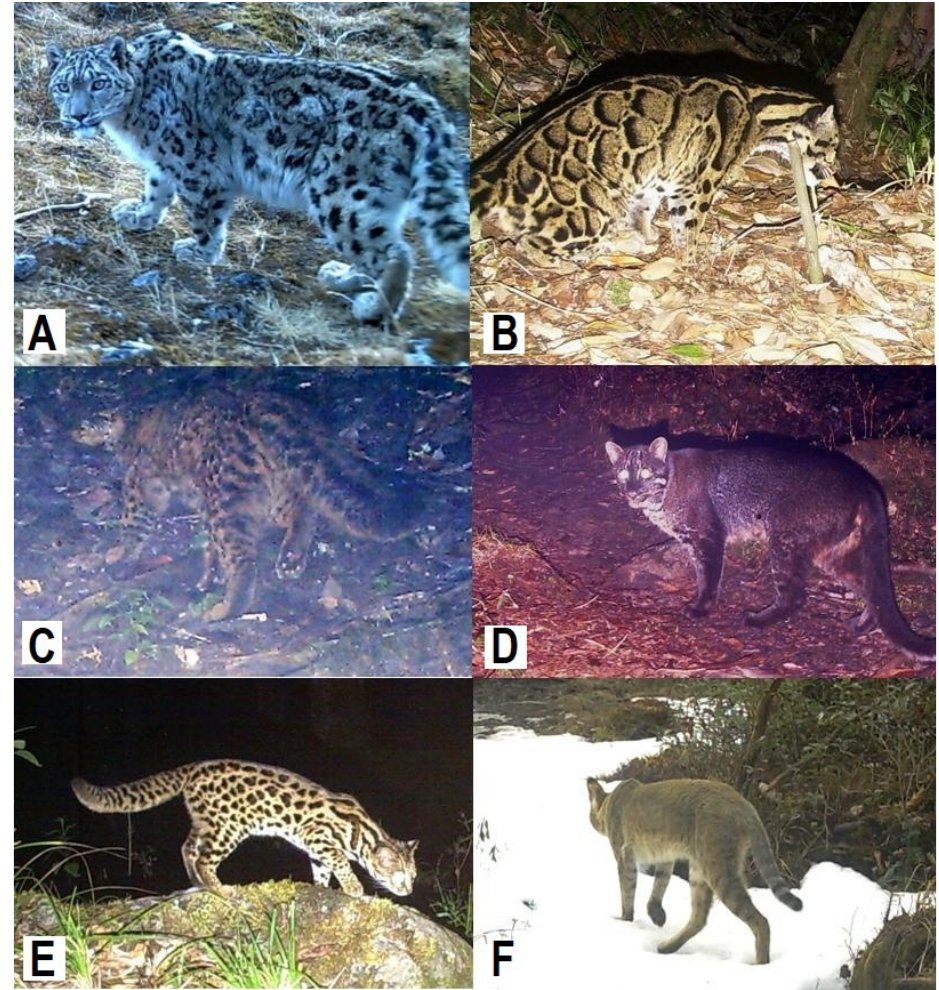
Figure 2. Camera trap photos of the felid species recorded in the study area; ( A ) snow leopard; ( B ) clouded leopard; ( C ) leopard; ( D ) Asiatic golden cat; ( E ) leopard cat; and ( F ) jungle cat.